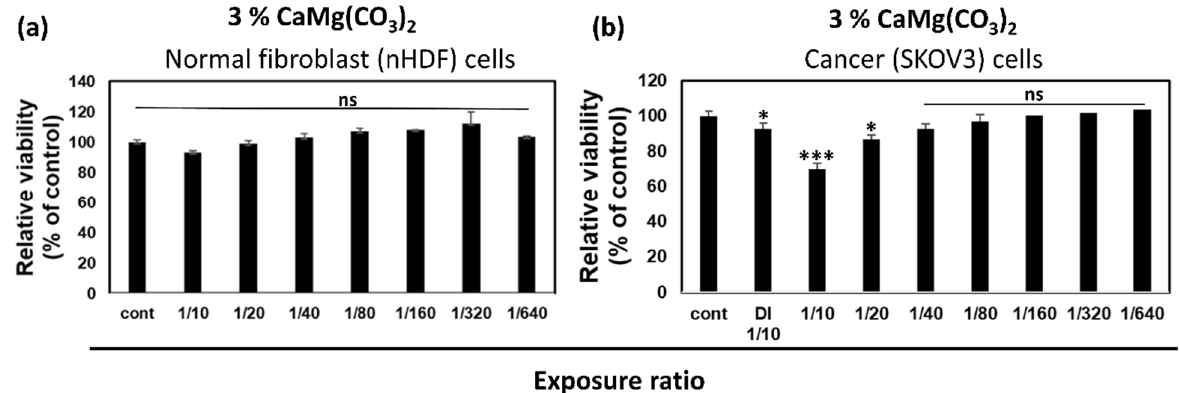
Figure 3. The cytotoxicity effects of 3% CaMg(CO 3 ) 2 on ( a ) normal fibroblast nHDF cell lines and on ( b ) cancer SKOV3 cell lines. Microsoft Excel was used to compute the significance (MS Office 365). Differences between treatment groups are shown by * p < 0.05, ** p < 0.01, and *** p < 0.001.